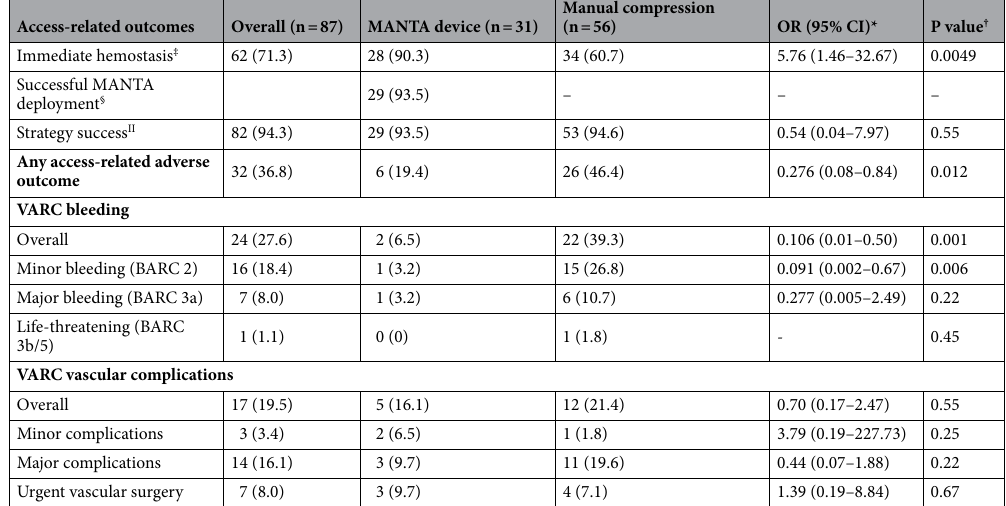
Table 3. Access related outcomes after Impella removal. Data are median (interquartile range) or number (percentage), as appropriate. BARC, Bleeding Academic Research Consortium; CI, confidence intervals; OR, odds ratio; VARC, Valve Academic Research Consortium. *OR and CI was calculated using manual compression as control group. † P values were based on Mann–Whitney-U test as appropriate. ‡ Immediate hemostasis was defined as a state of no relevant bleeding or oozing with no additional medical action needed directly after access closure. Only 86 patients could be included for this, 1 patient in the manual compression group could not be evaluated. § Successful MANTA deployment was defined as a correct release and placement of the MANTA toggle and plug and was evaluated at each closure by the responsible operator. II Strategy success was achieved when there were no signs of bleeding within 30 min after Impella removal and, in case of MANTA usage, if there was correct deployment of the vascular closure device and no complications had